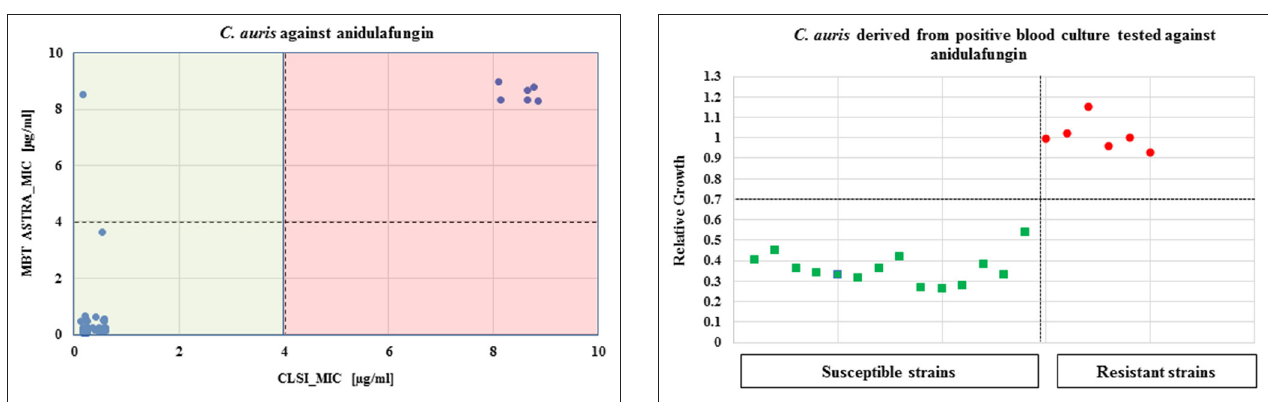
FIGURE 3 | MBT ASTR4 of C. auris isolates derived from positive blood cultures. A total of 20 C. auris isolates (resistant = 6, susceptible = 14) derived from positive blood cultures were tested against anidulafungin. The MBT ASTRA breakpoint was determined at I µ g/ml and an RG threshold of 0.7 for anidulafungin. All resistant and susceptible isolates were correctly